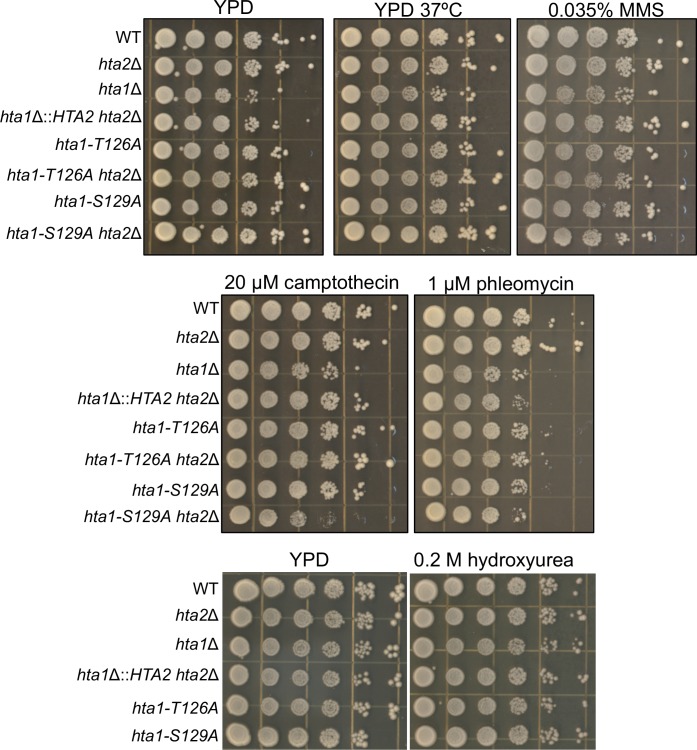
Drug sensitivity panels in H2A mutant strains.Ten-fold serial dilutions of the listed genotypes were pinned onto either YPD without drug, YPD at 37°C, or YPD with various DNA damaging agents: YPD+0.035% MMS, YPD+20 μM camptothecin, YPD+1 μM phleomycin, and YPD + 0.2 M HU. Plates were incubated for 3 days and photographed. The experiment was repeated 3 times; a representative experiment is shown.